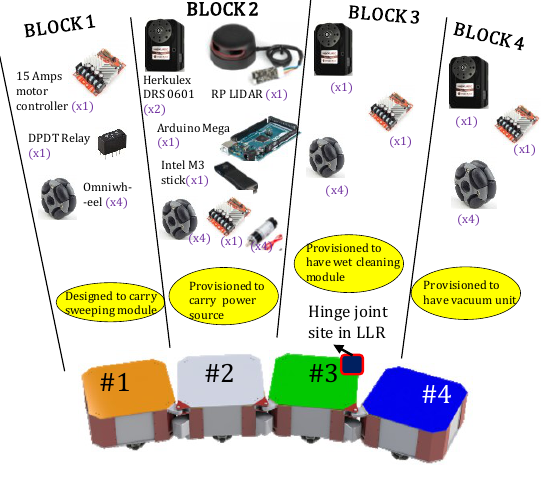
Figure 3. System architecture of